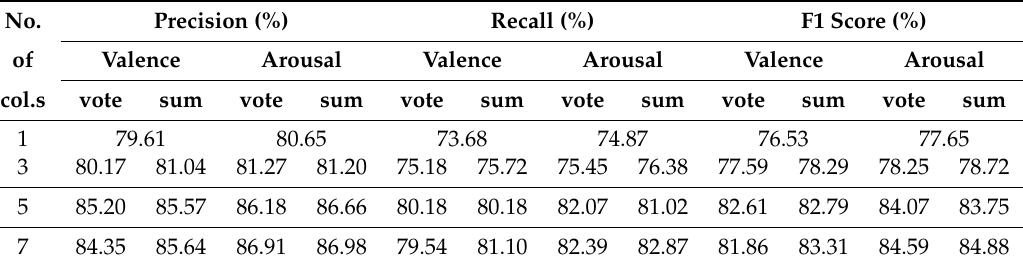
Table 3. The precision, recall and F1 score.